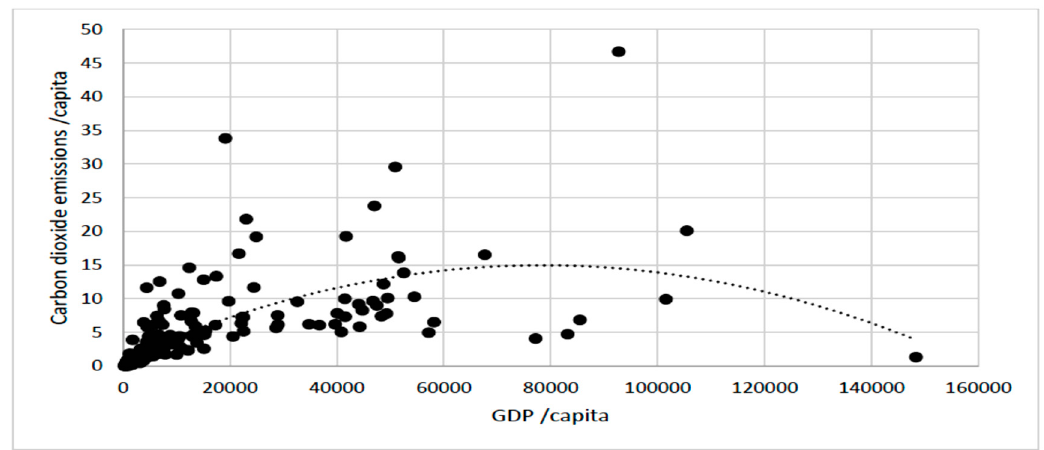
Figure 4. Graph depicting the results of the regression, i.e., model 3. The emission of CO 2 per capita is plotted on the X-Axis, while the GDP per capita is plotted on Y-Axis .